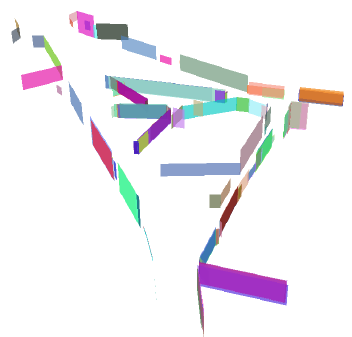
Figure 11: The distance of [ AB ] to [ OV ] (fig a) and the overlap between [ OV ] and [ AB ] projected on ( OV ) (fig b).